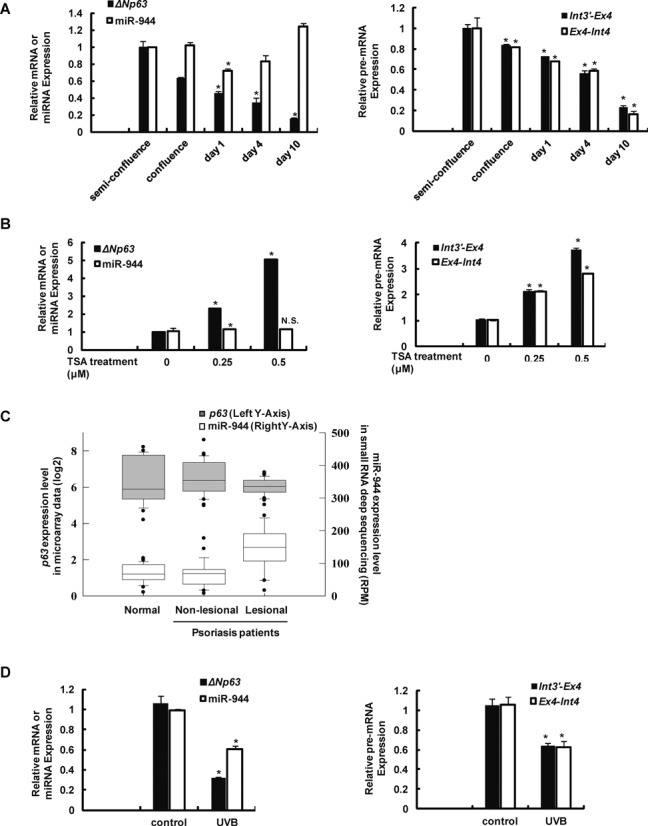
Discordant regulation of ΔNp63 and miR-944 expression under various conditions. (A) Human primary keratinocytes were differentiated by cultivating for the indicated time period after the replacement of culture medium with a medium containing a high calcium concentration (1.2 mM). The relative expression levels of ΔNp63 and miR-944 (left panel) and the expression of precursor TP63 mRNA (right panel) were examined during calcium-induced keratinocyte differentiation. Data represent the means ± SD of triplicate biological samples and are representative of four different experiments. *P < 0.05 versus semi-confluence, unpaired Student's t-test. (B) Human primary keratinocytes were treated with the indicated concentration of TSA for 4 days. The relative expression levels of ΔNp63 and miR-944 (left panel) and the expression of precursor TP63 mRNA (right panel) were examined. Data represent the means ± SD of triplicate biological samples and are representative of three different experiments. *P < 0.05 versus TSA 0 μM, unpaired Student's t-test. (C) Box plots showing normalized gene expression levels of TP63 and MIR944 in the skin of healthy individuals and in the lesional and non-lesional skin of psoriasis patients, which were examined using GEO deposited data (TP63 expression, GEO accession number: GSE14905; miR-944 expression, GEO accession number: 31037). (D) Human primary keratinocytes were exposed to 30 mJ/cm2 of UVB daily for 3 consecutive days. The relative expression levels of ΔNp63 and miR-944 (left panel) and the expression of precursor TP63 mRNA (right panel) were examined. Data represent the means ± SD of triplicate biological samples and are representative of three different experiments. *P < 0.05 versus control, unpaired Student's t-test.